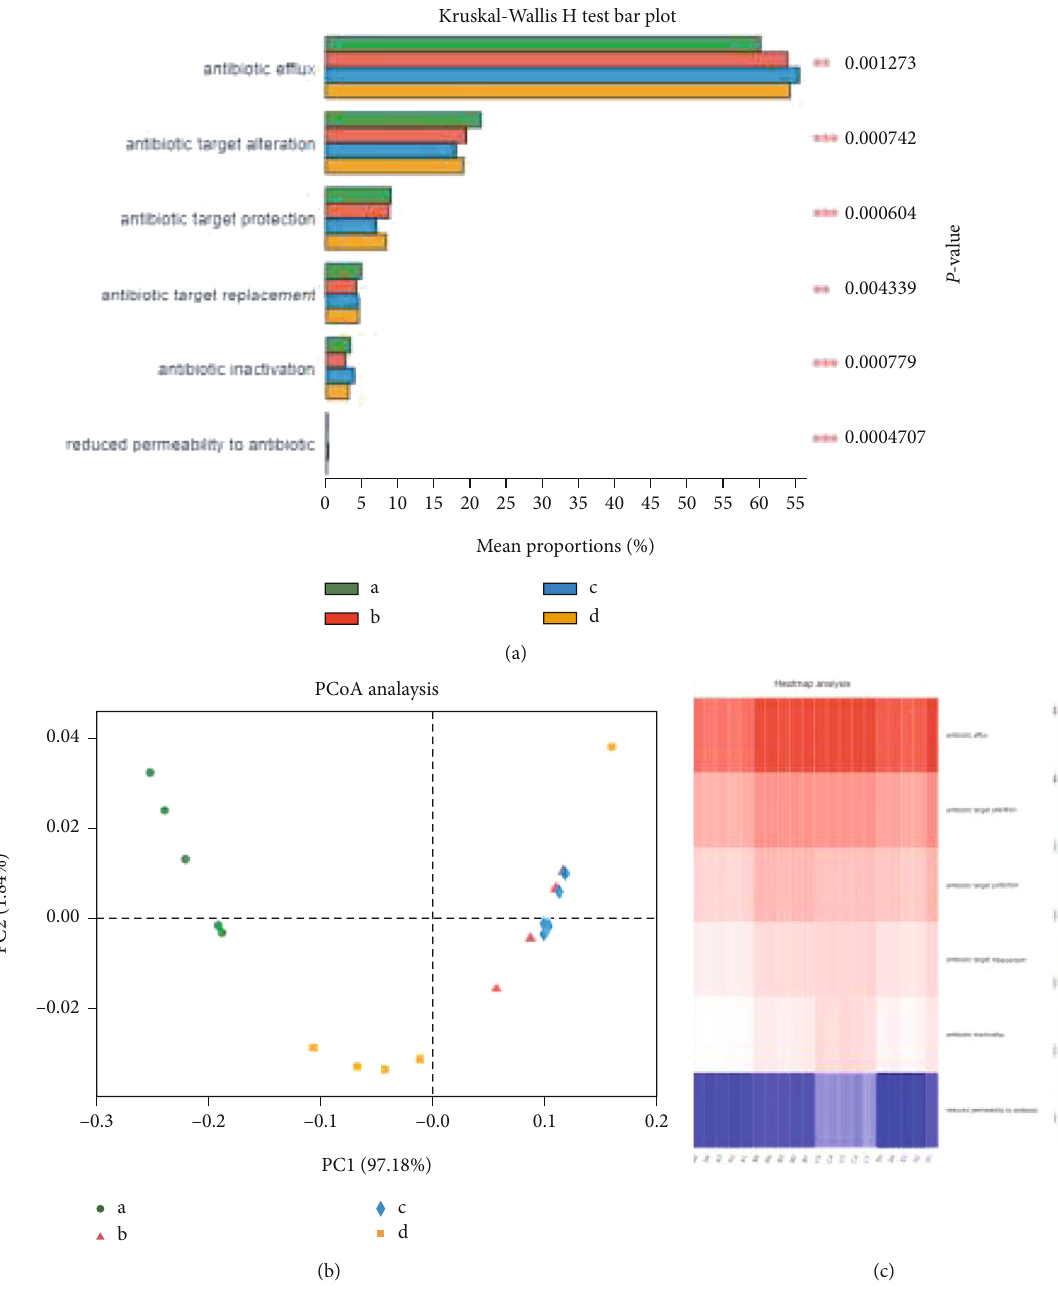
Figure 6: ARG types present in each sample of wastewater. (a) ARGs types. (b) PCoA of the gene types found in the bacterial community. (c) Functional comparisons between various groups of genes and numerous groups of